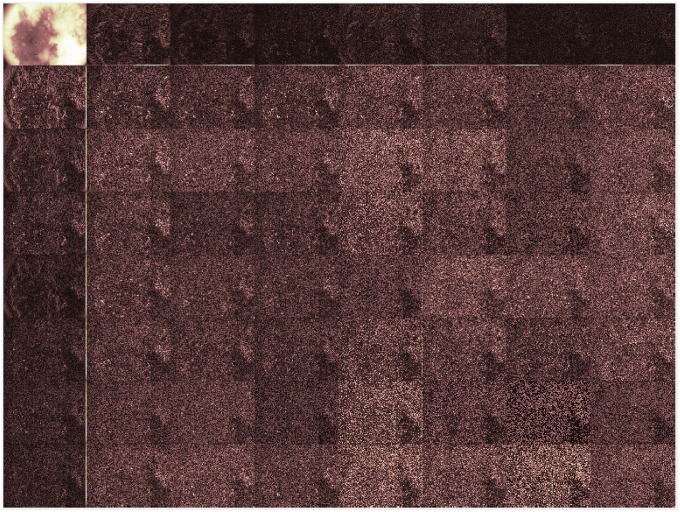
The wavelet packet transform (WPT) decomposition.